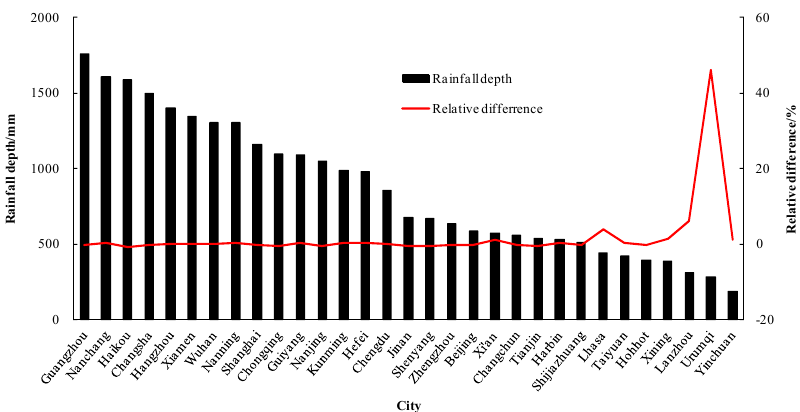
Figure 4. Relative differences in rain garden (RG) design depth for different cities in China, while using IDF and NDR methods when σ = 3 (DA/SA = 20:1, runoff coefficient was 0.9 for impervious surface and infiltration rate was 1.5 m/d).